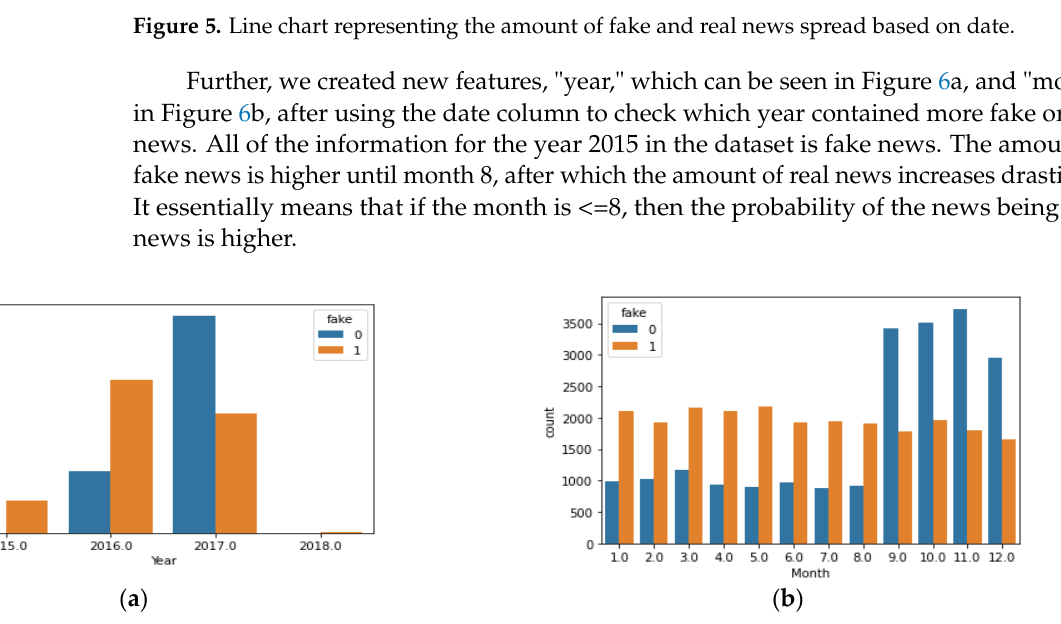
Figure 6. Fake and real news counts for year and month; ( a ) year-wise fake and real news; ( b ) month-wise fake and real news.